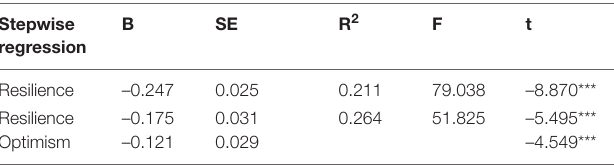
TABLE 2 | Analysis results of